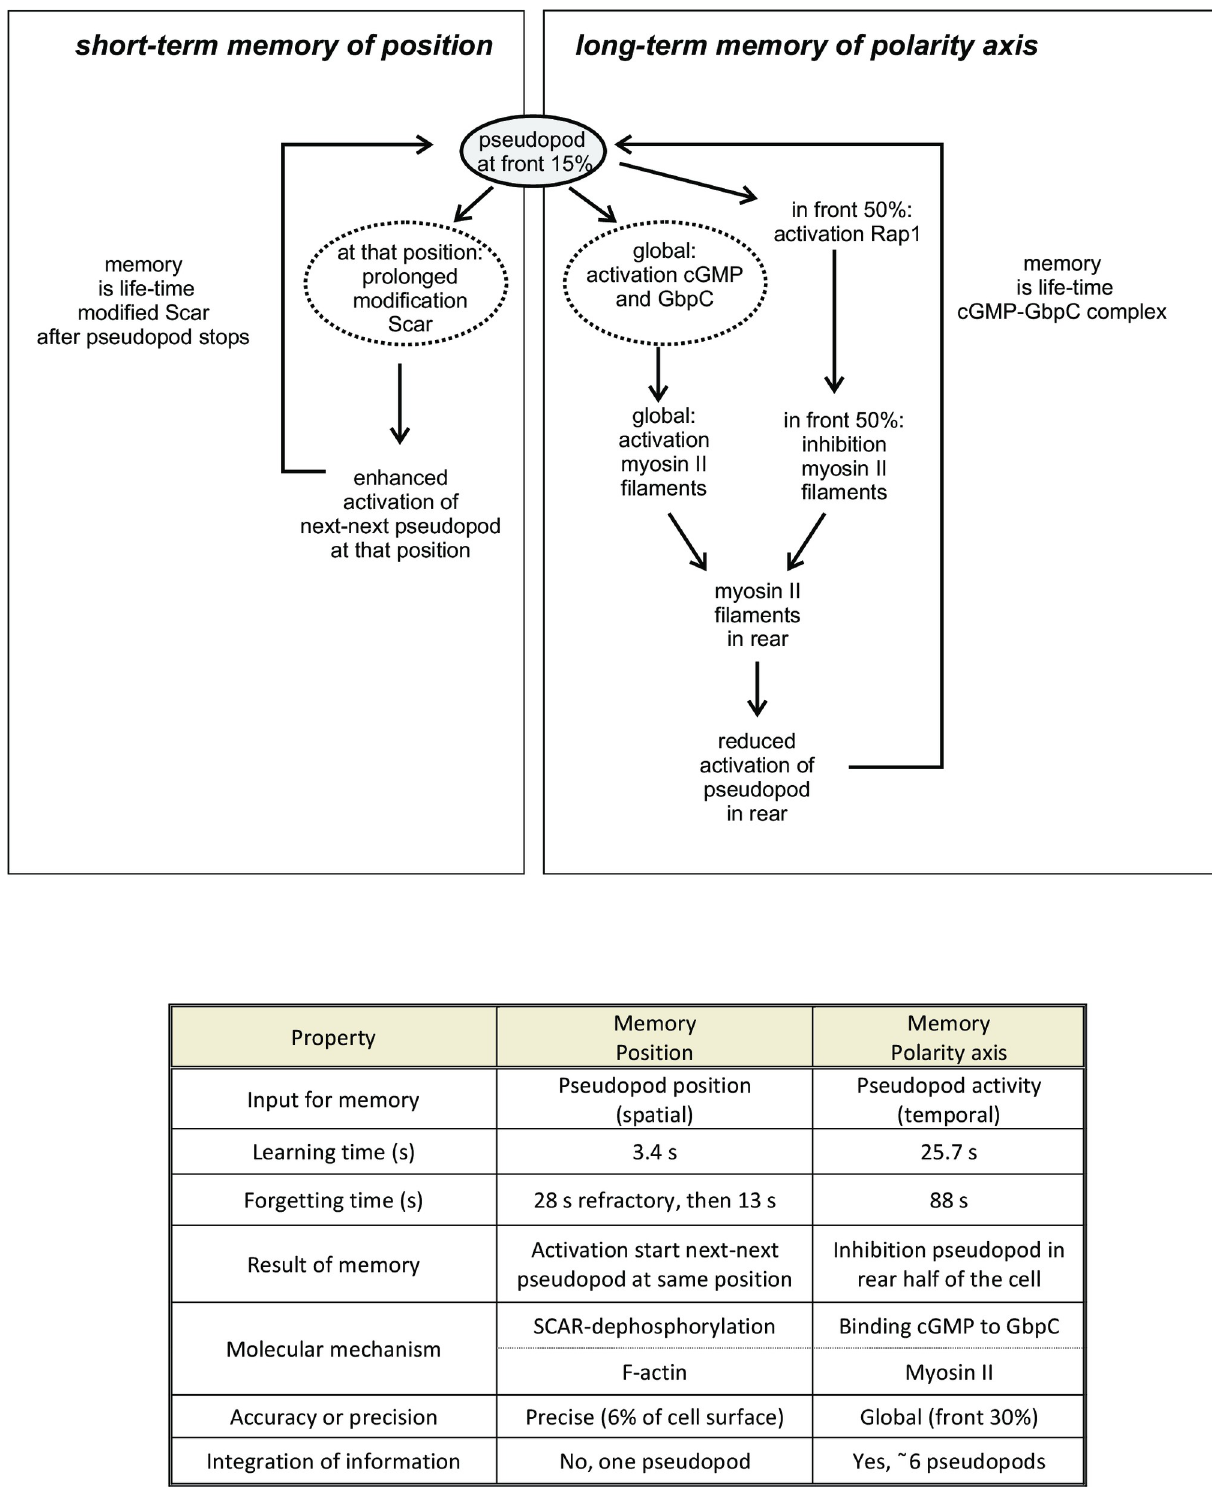
Fig 9. Schematic and properties of short-term memory of position and long-term memory of polarity axis. The extending pseudopod provides signals to two memory systems. Left part: at the position of the extending pseudopod SCAR becomes modified, which enhances the probability to start the next-next pseudopod at that local position. Right part: the extending pseudopod enhances guanylyl cyclase activity generating fast diffusing cGMP in the entire cell, which binds to GbpC and induces myosin filaments in the entire cell. The extending pseudopod also induces Rap1 activation that inhibits